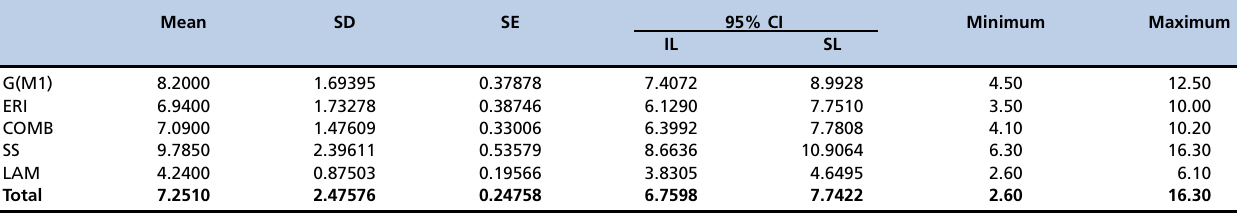
Table 1 - Motor evoked potential results: latency in the lower limbs in each group.